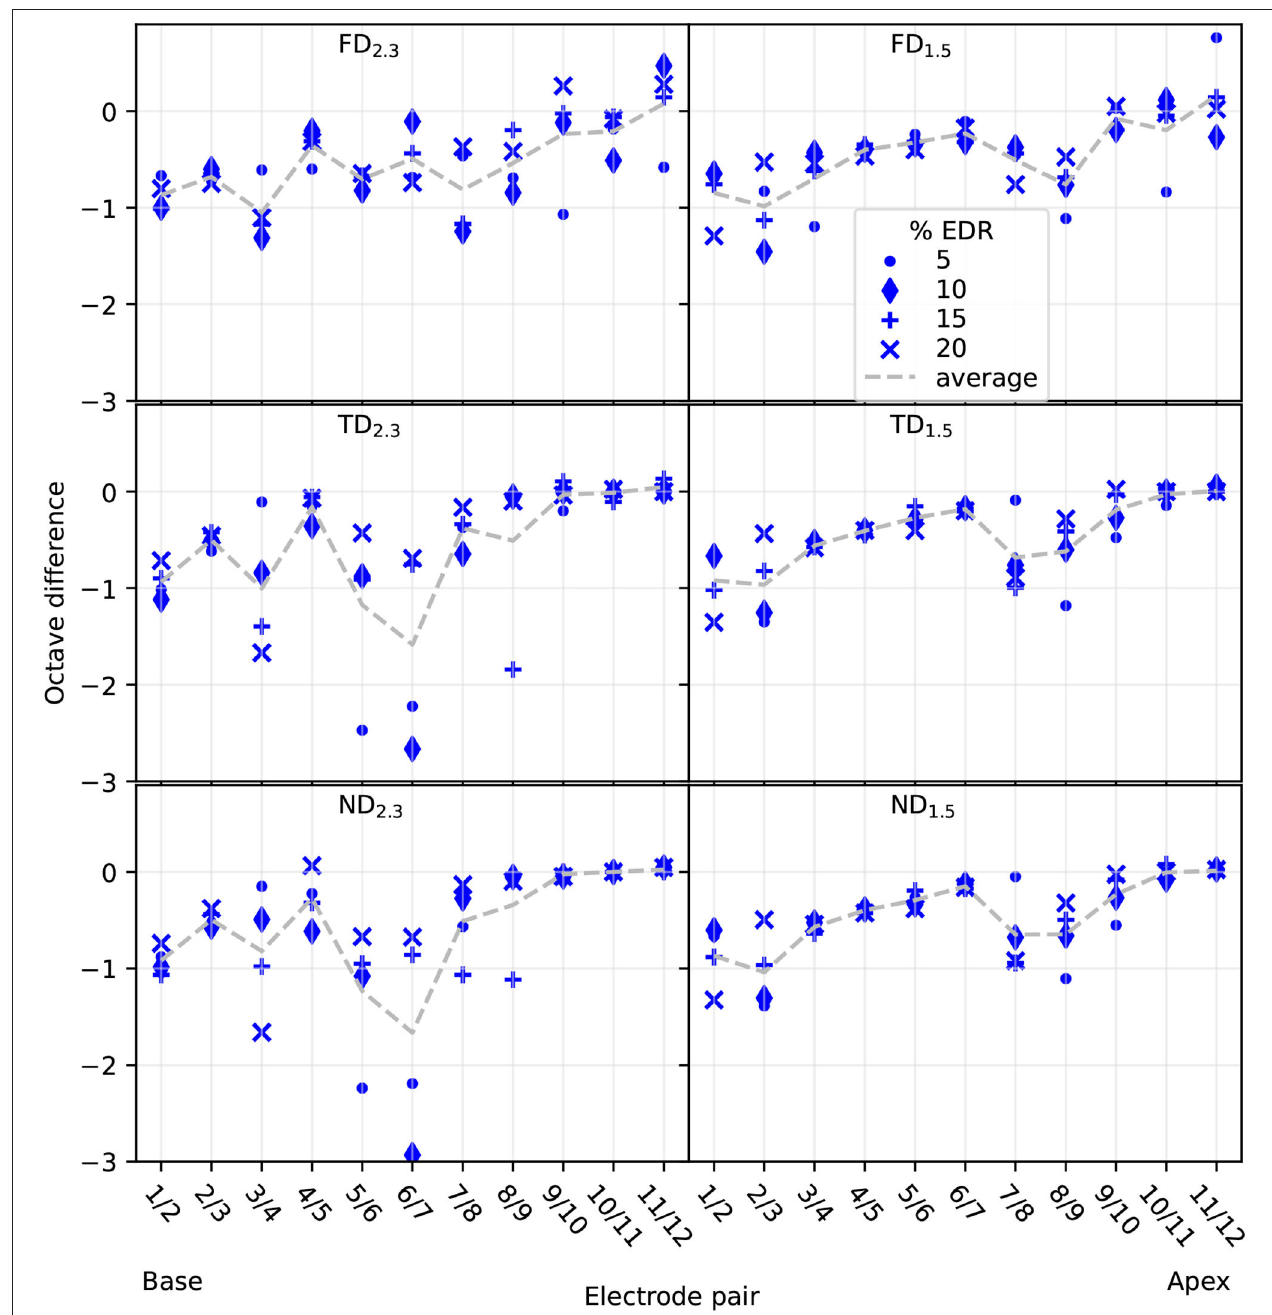
FIGURE 11 | Reconstructed pitch difference between neighboring electrodes. Differences displayed for 5, 10, 15, and 20% of EDR, as well as the average of the four differences. Electrode pair refers to which electrodes were used to compute the difference.